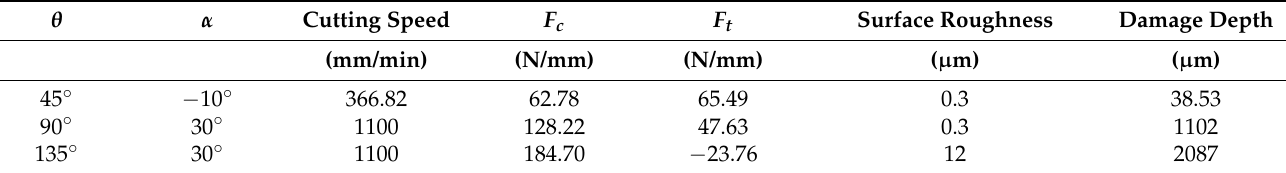
Table 8. Optimal combinations of cutting velocity and rake angle for different fibre orientations at a constant depth of cut of 100 µ